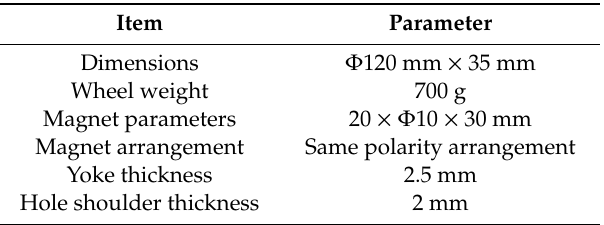
Table 1. Magnetic wheel parameter